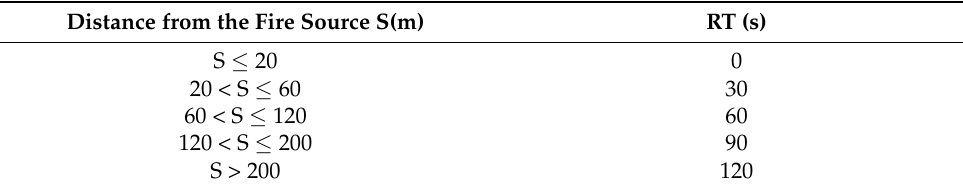
Table 7. RT of evacuation in different distance from the fire source.